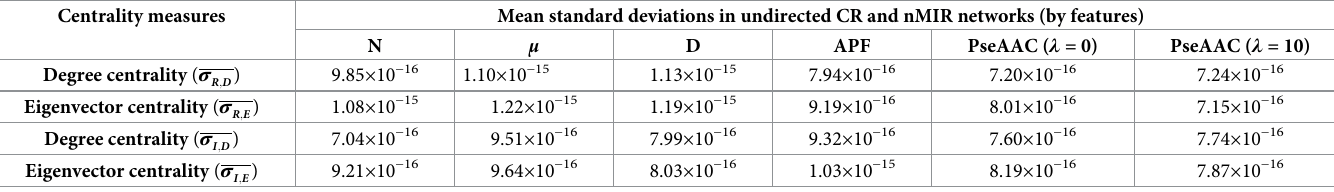
Table 3. The mean standard deviation results for the centralities of undirected networks (SCOP). Centrality